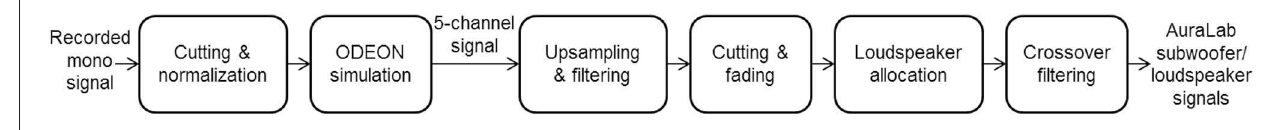
simulation in ODEON, all signal processing steps (see Figure 2 ) were done in the MATLAB environment v. R2016b (MathWorks, Natick, MA,